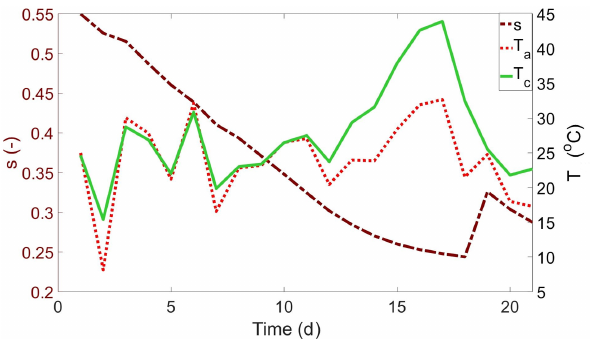
Figure 2. Example of numerically generated time series of soil moisture ( s ; dot-dashed burgundy line), air temperature ( T a ; dotted red line), and canopy temperature ( T c ; solid green line), for rainfed cropping. The left axis represents soil moisture and the right axis temperature. The model was run for 21d with the baseline environ- mental conditions. Parameter values are listed in Table